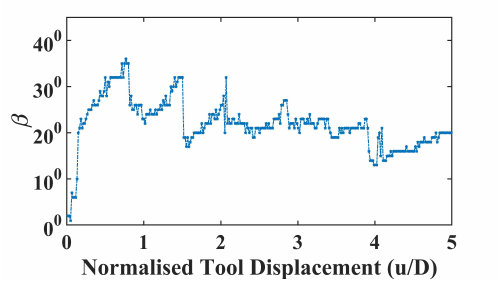
Figure 5. Evolution of inclination angle of shear band, β , measured with respect to the direction of